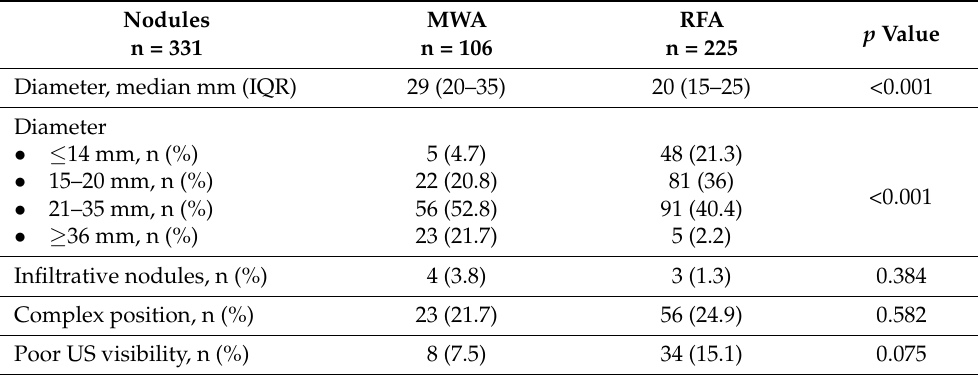
Table 2. Features of all included HCC nodules (n = 331) treated with thermal ablation.